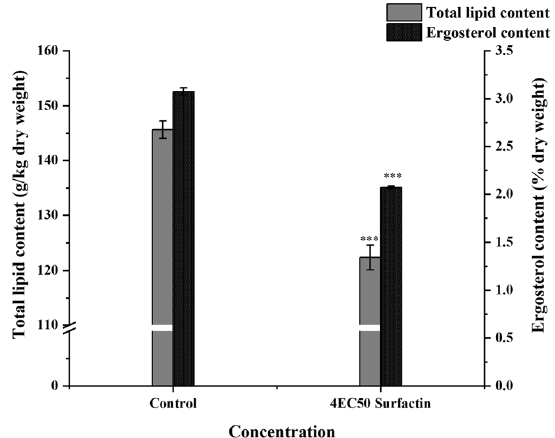
Fig. 7 Total lipid and ergosterol levels in mycelia of B. cinerea in the control and 4 EC 50 surfactin groups. The error bars represent the SEs of 3